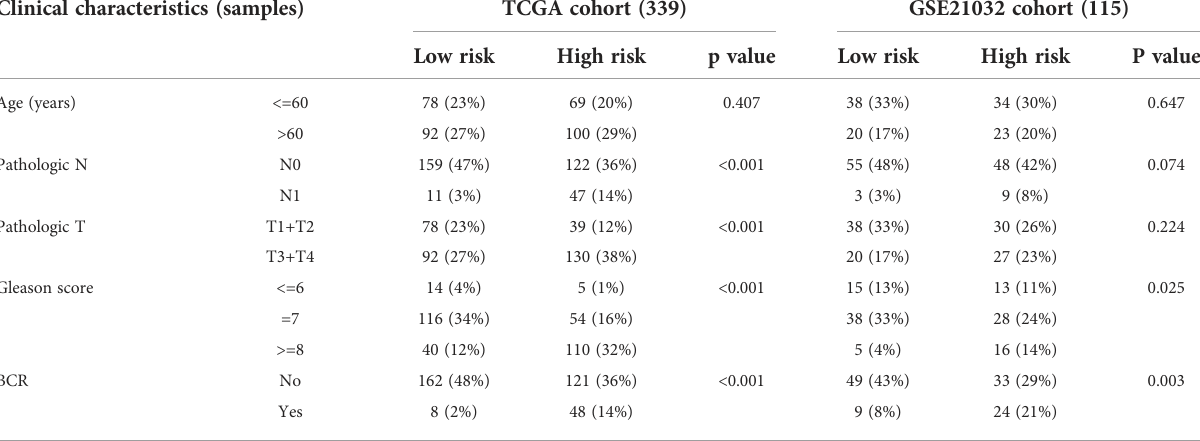
TABLE 1 Clinical characteristics of PRAD patients in different risk clusters. Clinical characteristics